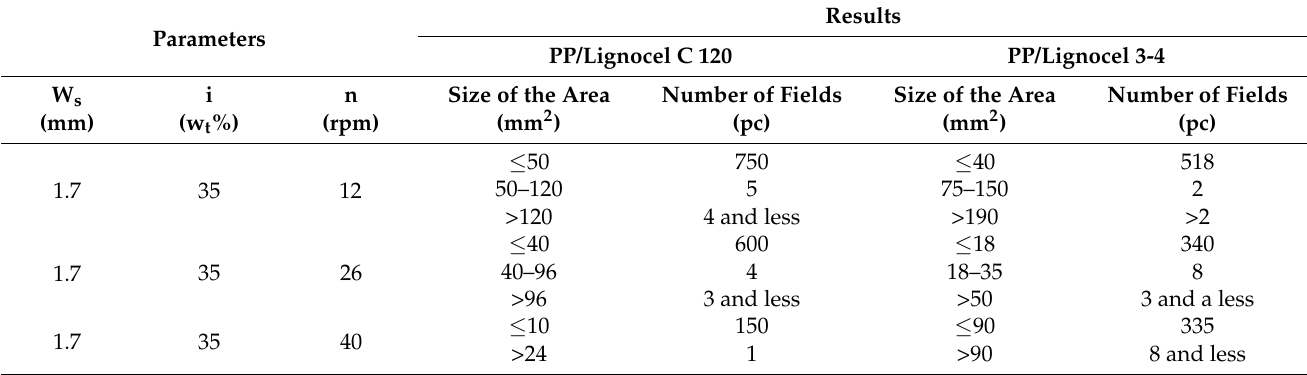
Table 5. Results of the analysis of WPC composite images for different values of rotational